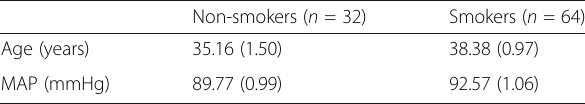
Table 1 Characteristics of the subjects between non-smokers and smokers